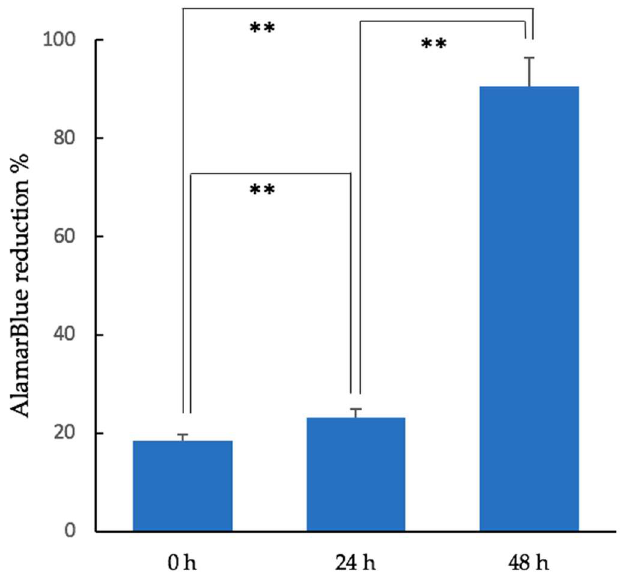
Figure 2. Results of the AlamarBlue assay (fluorescence excitation wavelength: 570 nm; fluorescence emission wavelength: 600 nm) of MC3T3-E1 cells in the cellular cubic composite over 48 h (unpaired t -test, ** p < 0.01; Error bars represent the standard deviation).